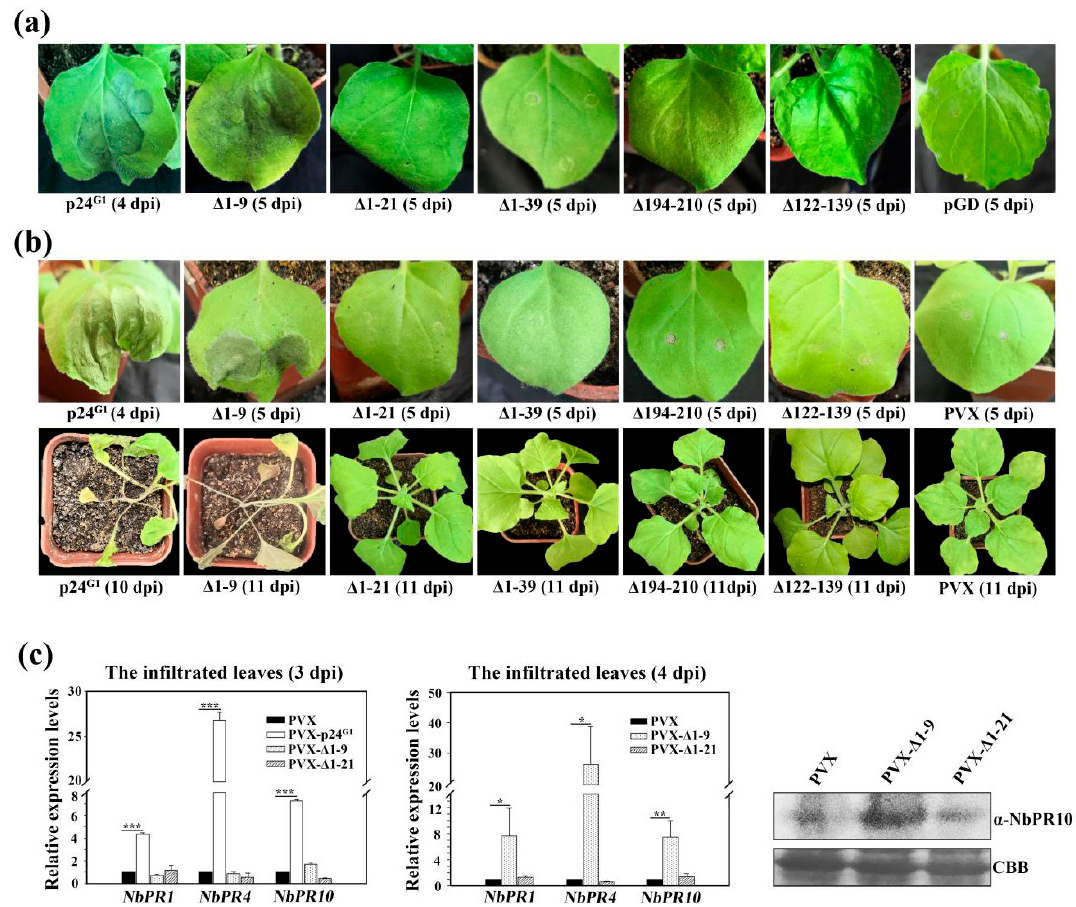
Figure 7. Analysis of the pathogenic activity of p24 of grapevine leafroll-associated virus 1 (p24 G1 ) mutants. ( a,b ) Phenotypes of N. benthamiana induced by p24 G1 mutants expressed from pGD ( a ) or PVX ( b ) vector. ( c ) Effects of p24 G1 mutants on the expression of NbPR1 , NbPR4 and NbPR10 at 3 (left panel) and 4 (middle and right panel) dpi. Infiltrated leaves at 3 and 4 dpi were used for extraction of total RNA and protein. PVX – p24 G1 -infiltrated leaves showing local necrosis at 4 dpi could not be used for analysis. qRT-PCR results are shown as mean ± standard deviation of three independent experiments. Standard deviation is denoted by error bars. * p < 0.05, ** p < 0.01, *** p < 0.001. Right panel indicates NbPR10 accumulation at 4 dpi detected by Western blot using anti-NbPR10 antiserum. CBB staining served as a loading control.